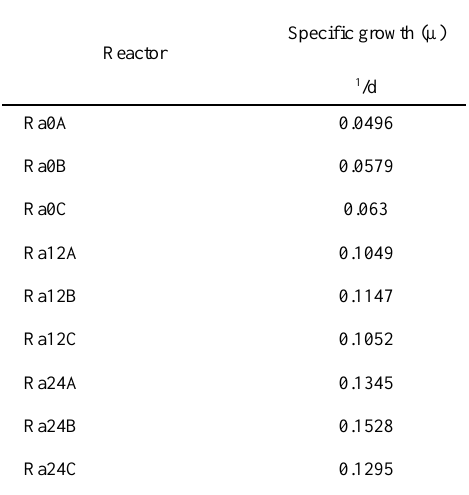
Table 2.Chlorophyll-a specific growth rate in each reactor